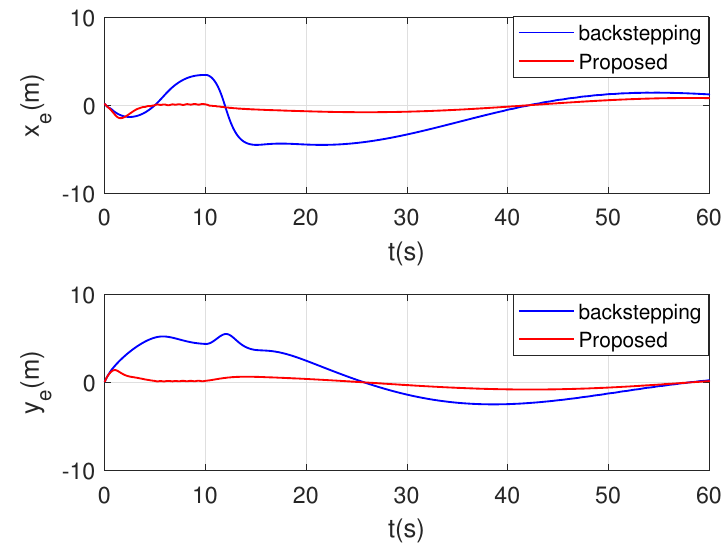
Figure 7. Position error of trajectory tracking.